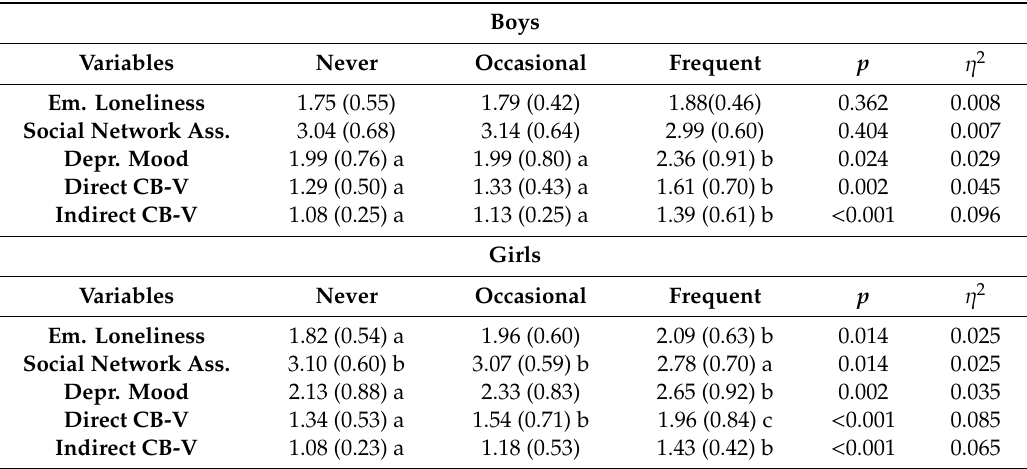
Table 3. Means (standard deviation) for loneliness, depressive mood and cyberbullying victimization in adolescent boys and girls with di ff erent cyber-control victimization experiences. Boys Variables Never Occasional Frequent p η